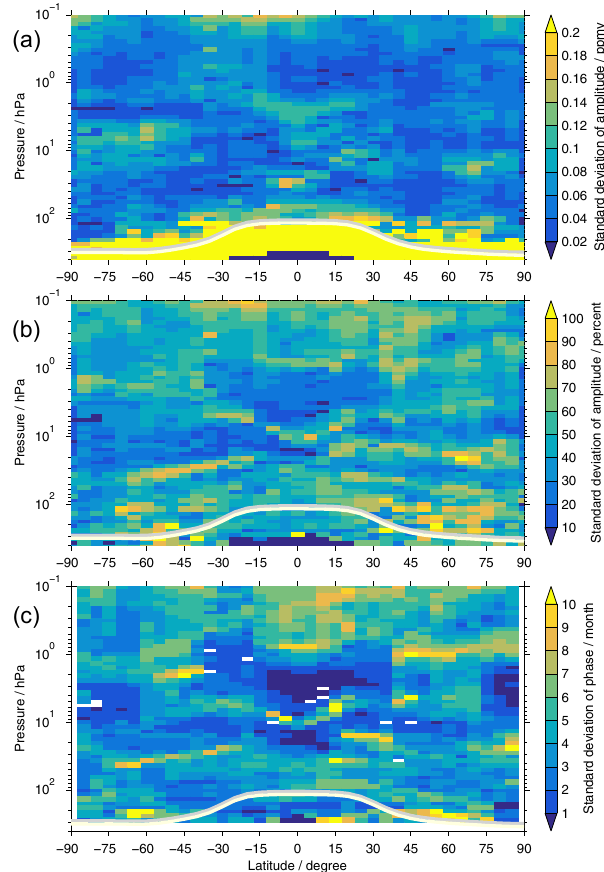
Figure 14. As Figs. 5 and 10 but here focusing on the QBO varia-